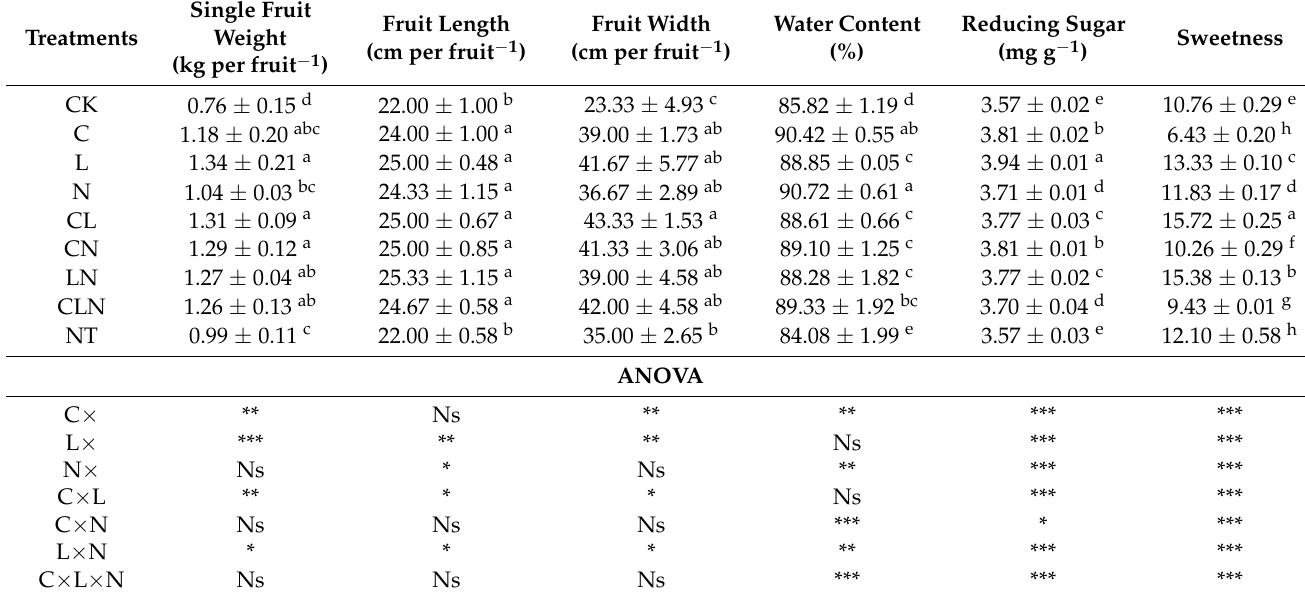
Table 5. Growth analysis of fruit under treatments in fruiting stage in